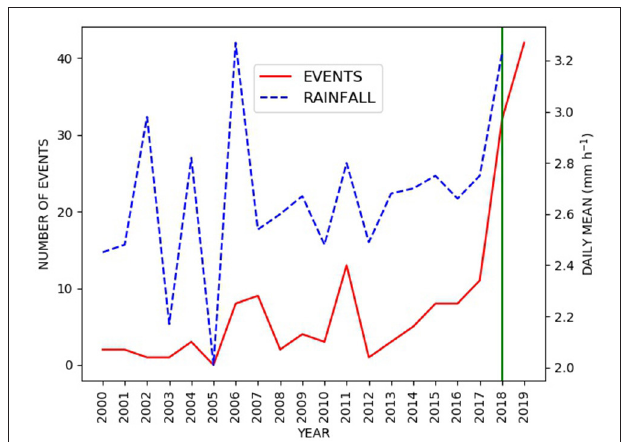
FIGURE 4 | Annual number of severe weather disaster events and mean annual rainfall over Tanzania from 2000 to 2019. The green line indicates the start of improvement in data capturing system at the